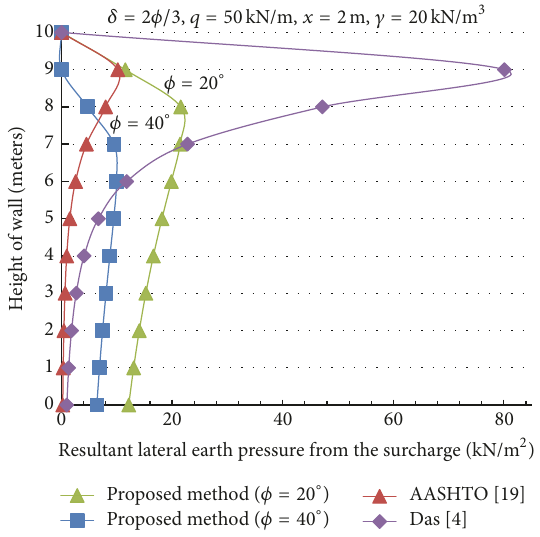
Figure 14: Resultant lateral earth pressure from the surcharge for the proposed method and AASHTO [19] and Das